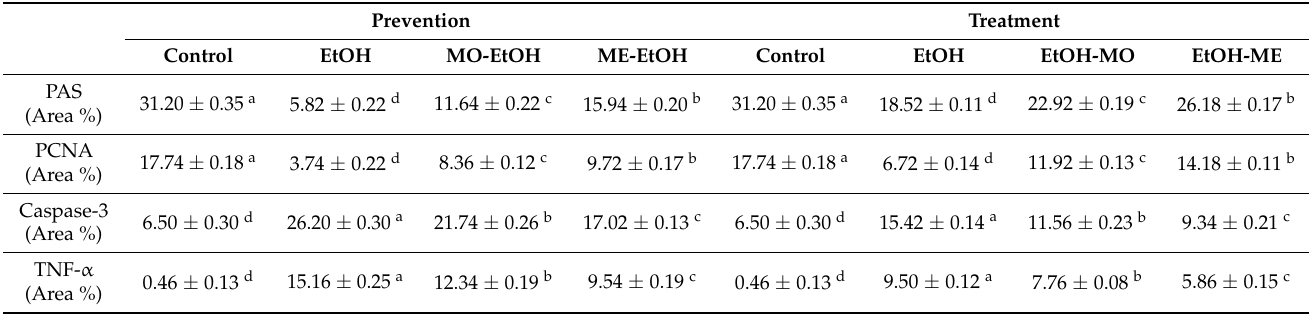
Mean ± SE. Means denoted within the same row with different superscripts are significantly different ( p <